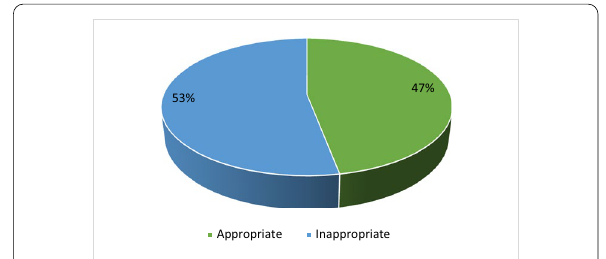
Fig. 1 Pre-intervention level of appropriateness at Mengo Hospital